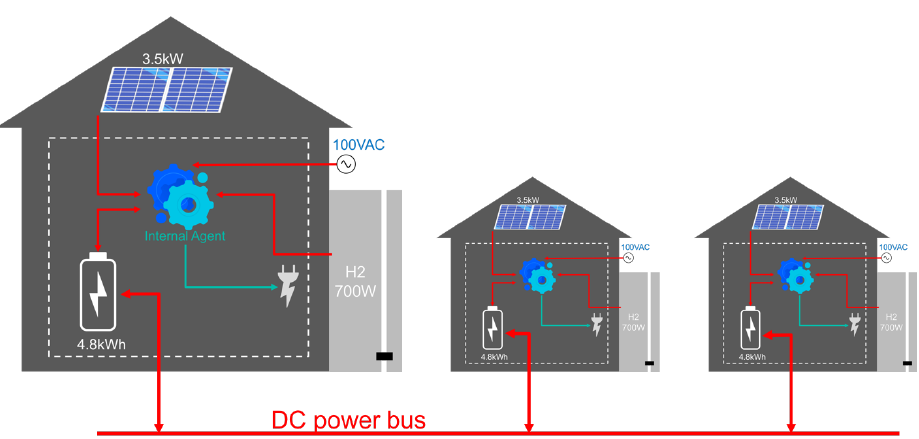
Figure 1. Home system configuration and microgrid topology of the baseline